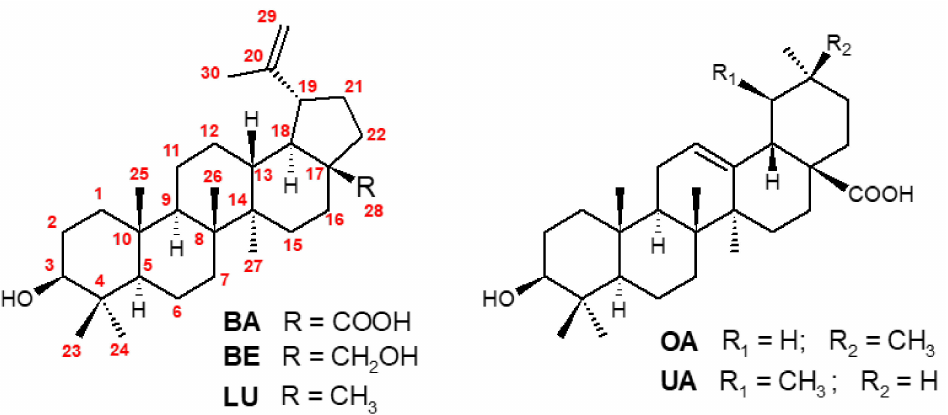
Figure 1. Structures of betulinic acid (BA), betulin (BE), lupeol (LU), oleanolic (OA) and, ursolic (UA)